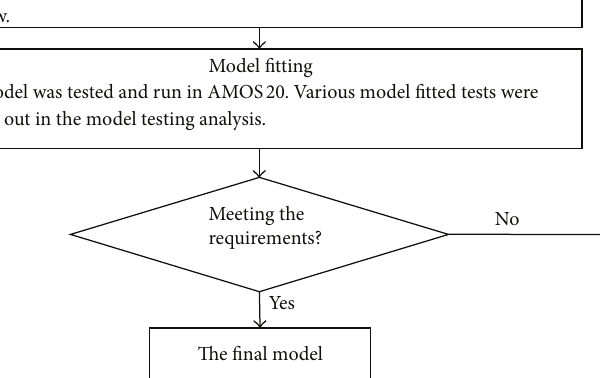
Distance before curve